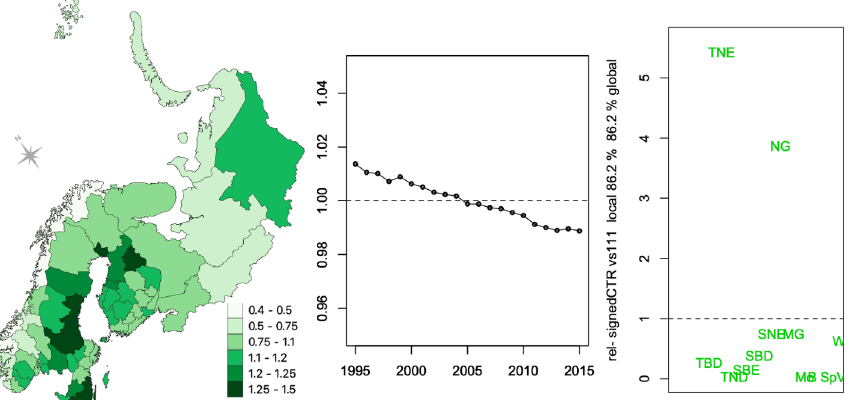
Figure 3. Best principal tensor representing 86.26% of the variability in vegetation fractional cover per 69 districts × 21 years × 12 PFTs. The plots show the spatial ( left ), temporal ( middle ), and vegetation PFT ( right ) component weights of the relative signed CTR (a score of ± 1, the uniform equal contribution, is indicated by the horizontal dashed line on the two figures on the right-hand side). The horizontal spread in the one-dimensional PFT plot is used simply to clarify the display; see Appendix A for the PFT acronyms (Table A2).